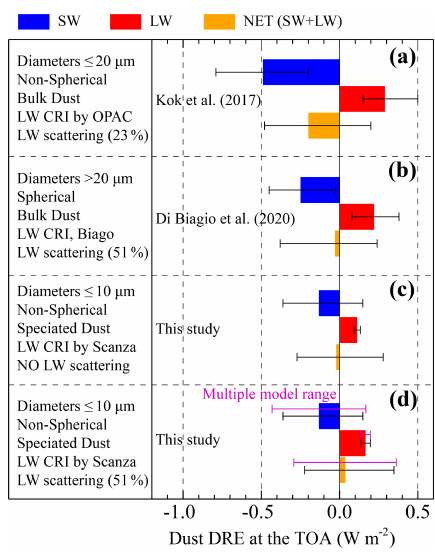
Figure 17. Comparison of global mean shortwave (SW), long- wave (LW), and net (NET) DRE at the TOA obtained by Kok et al. (2017) (a) , Di Biagio et al. (2020) (b) , and this study (c, d) . In (c) and (d) , black error bars denote estimates based on CAM5 and CAM6 with mineral uncertainty in C1999 and J2014. Purple bars in (d) represent estimates based on multiple models (CAM5, CAM6, ModelE2, GFDL, and MONARCH with both soil atlases), and the longwave DRE in CAM is scaled up by ∼ 1 . 5. Note that the uncertainty of the longwave DRE is obtained based on CAM5, CAM6, and MONARCH. Texts to the left describe detailed infor- mation used for corresponding estimates. The description of this study applies to CAM5 and CAM6 only. GFDL also has a cut-off di- ameter of 10µm. ModelE2 and MONARCH consider dust particles with the diameter up to 50 and 20µm, respectively. Kok et al. (2017) utilized the complex refractive index (CRI) from Optical Properties of Aerosols and Clouds (OPAC) (Hess et al., 1998) or Volz (1973). The estimate in Di Biagio et al. (2020) is based on the CRI obtained from Di Biagio et al. (2017) in the longwave spectral range and from Balkanski et al. (2007) in the shortwave spectral range includ- ing dust > 20µm in diameter. The speciated-dust model utilizes the CRI of each mineral taken from Scanza et al. (2015). Dust optics in MONARCH are for longwave and shortwave optics (see